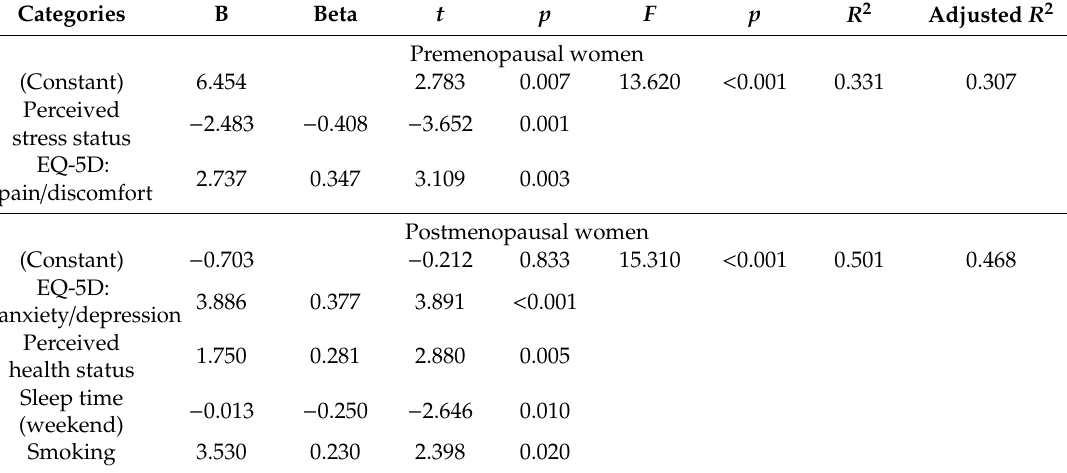
Table 4. Factors associated with depressive symptoms according to